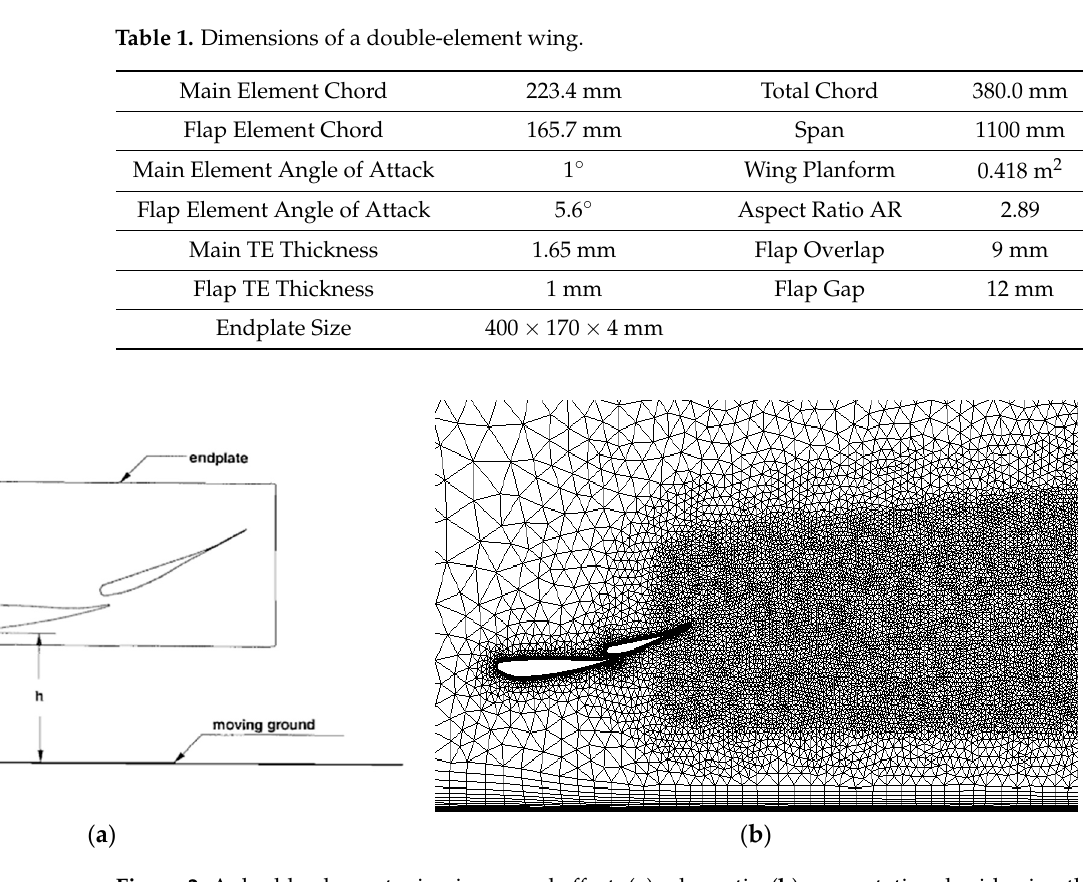
Figure 2. A double-element wing in ground effect: ( a ) schematic, ( b ) computational grid using the ICEM-CFD software.